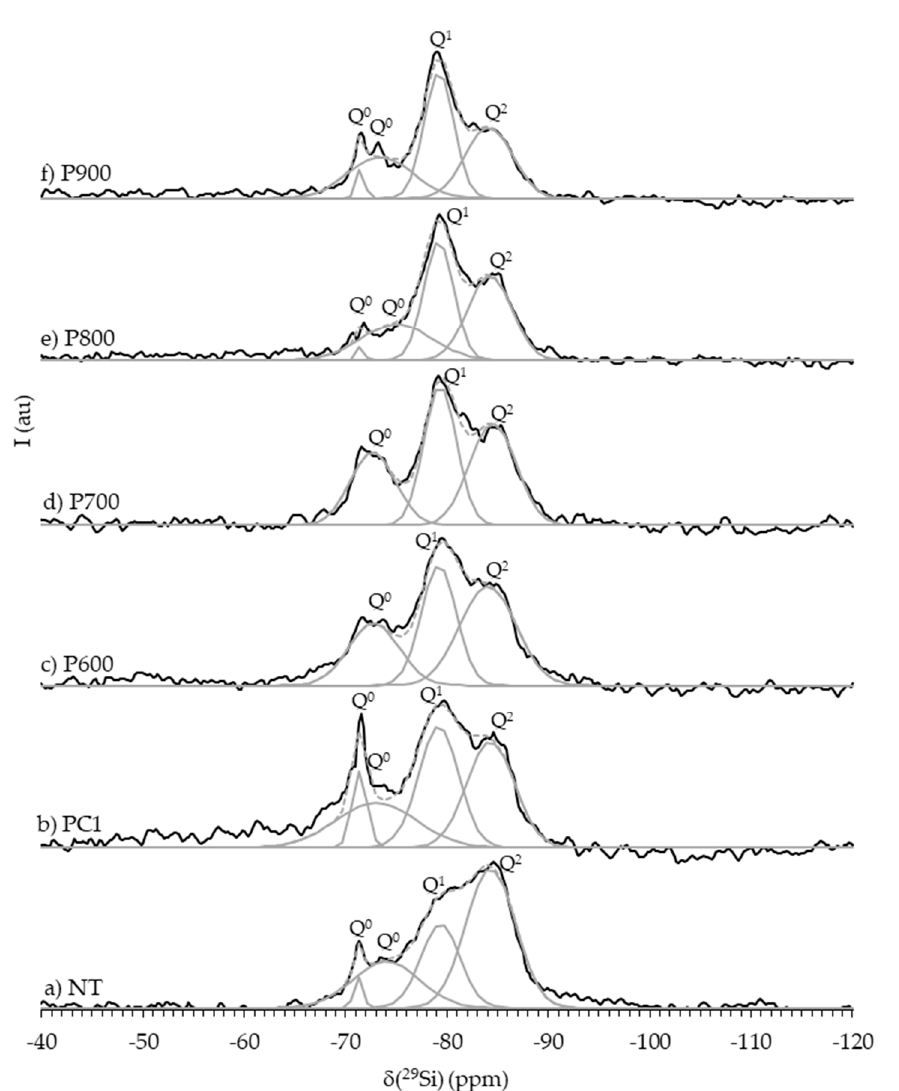
Figure 22. 29 Si-NMR spectra of NT at 90 days, PC1 and RC pastes at 28 days (peak deconvolution is displayed in gray). Q n refers to the number of orthosilicate units (n) attached to a SiO 4 tetrahedron (Q).